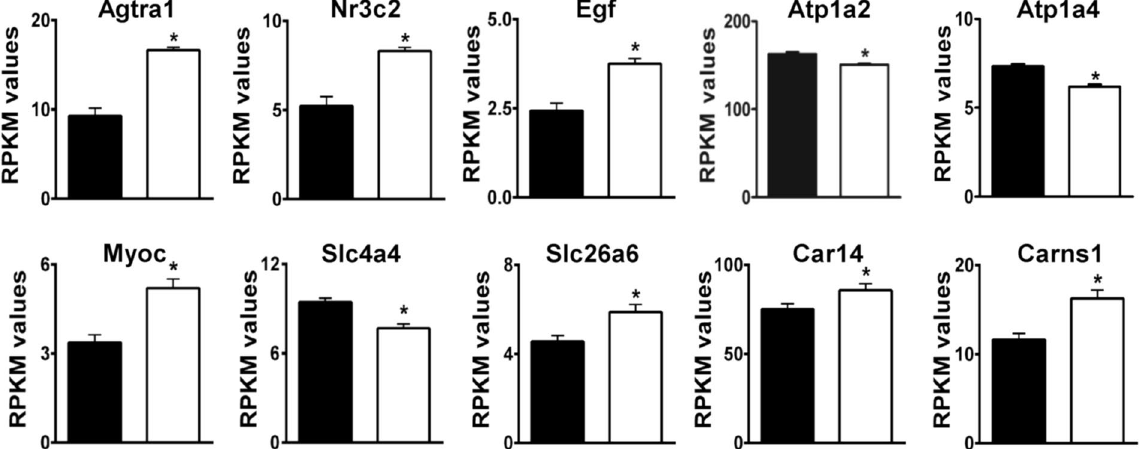
Figure 6. Differential expression of genes with potential for adaptation via Na + -loading or regulation of pH i . Genes in the top row have the potential to contribute to increased contractility via regulation of Na + -loading. Genes in the second row are affected by or involved in intracellular acid-base homeostasis. RPKM values for WT (black bars) and AE3-null (white bars) hearts are shown. Values are means ± SE; n = 4 for each genotype; * p ≤ 0.01 vs WT controls, except Car14 (p = 0.019), which encodes CA XIV, an AE3-interacting